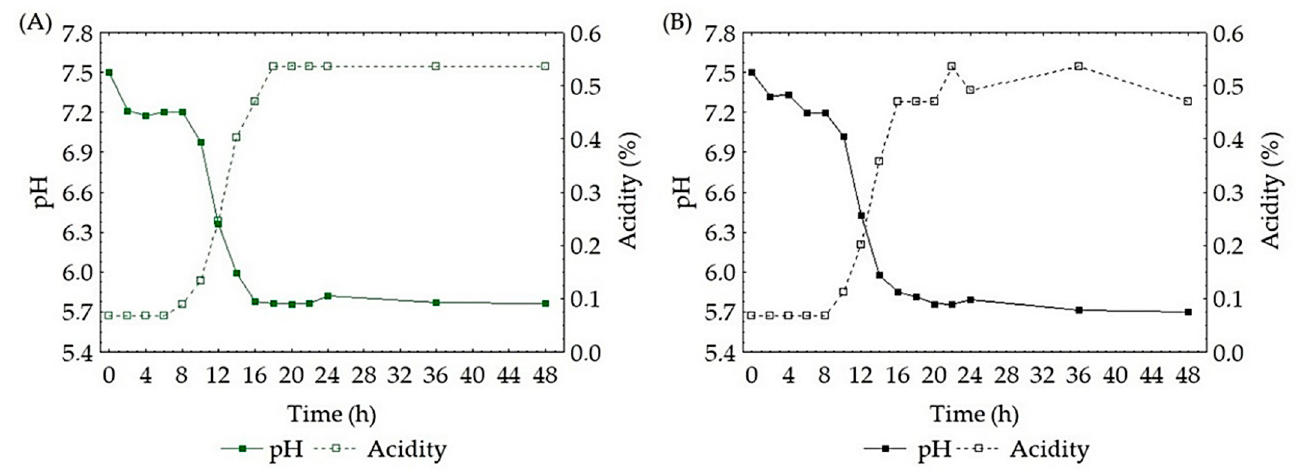
Figure 5. Monitoring pH of acidity in the best fermentation conditions of passion fruit juice ( A ) and passion fruit added with green tea ( B ).